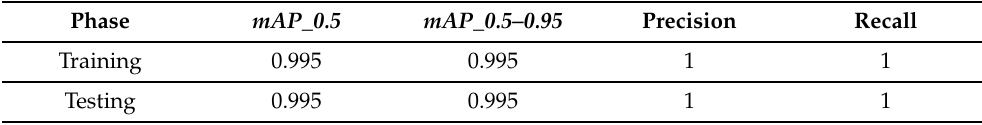
Table 4. YOLOv5s yellow sticky card model